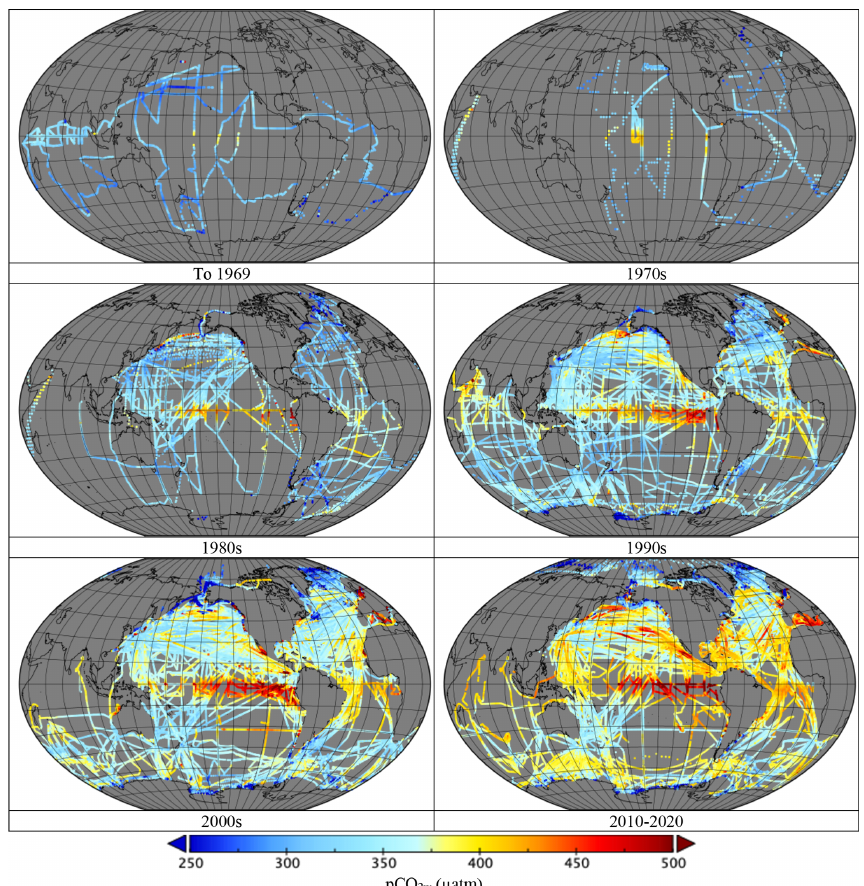
Figure 11. Mean pCO 2w (µatm) divided into decades: 1751 ROIs to 1969, 1636 in the 1970s, 9090 in the 1980s, 42548 in the 1990s, 97313 in the 200s and 120415 from 2010 to